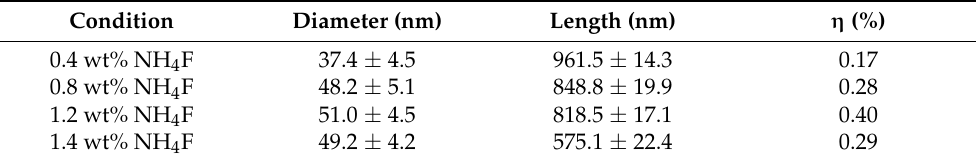
Figure 13. SEM images of as-prepared TNTs grown onto ITO. ( a – d ) Top view images for: ( a ) 0.4 wt% NH 4 F; ( b ) 0.8 wt% NH 4 F; ( c ) 1.2 wt% NH 4 F; ( d ) 1.4 wt% NH 4 F. ( e – h ) Cross-section images for: ( e ) 0.4 wt% NH 4 F; ( f ) 0.8 wt% NH 4 F; ( g ) 1.2 wt% NH 4 F; ( h ) 1.4 wt% NH 4 F. Reprinted from reference [30] under license CC BY 4.0. Table 2. Average diameter, length and photo-electron conversion efficiencies ( η ) of as-prepared TNTs under different conditions. Reprinted from Aiempanakit et al., 2020, under license CC BY